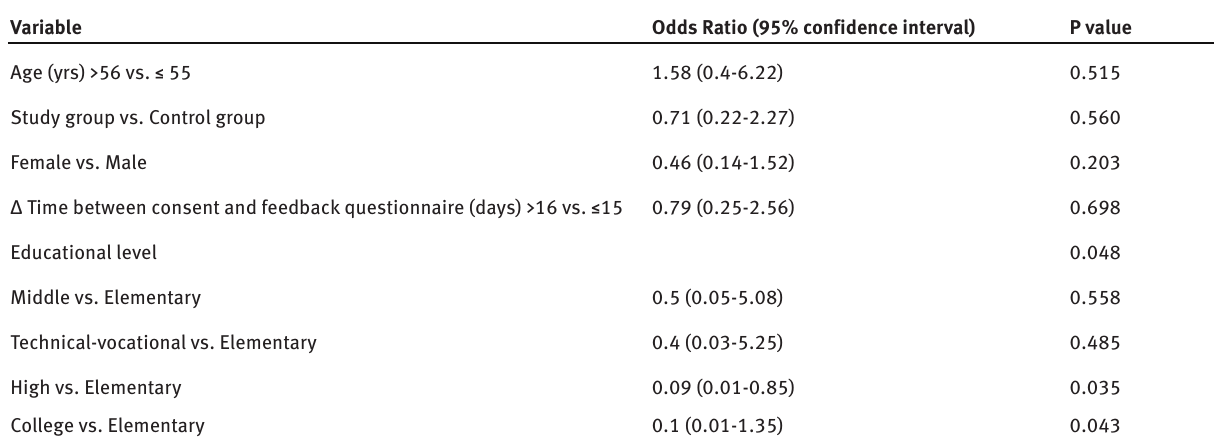
Table 4: Results of multivariate binary logistic regression analysis comparing the factors affecting the probability of making errors: 0 errors (20 patients) vs. ≥1 error (50